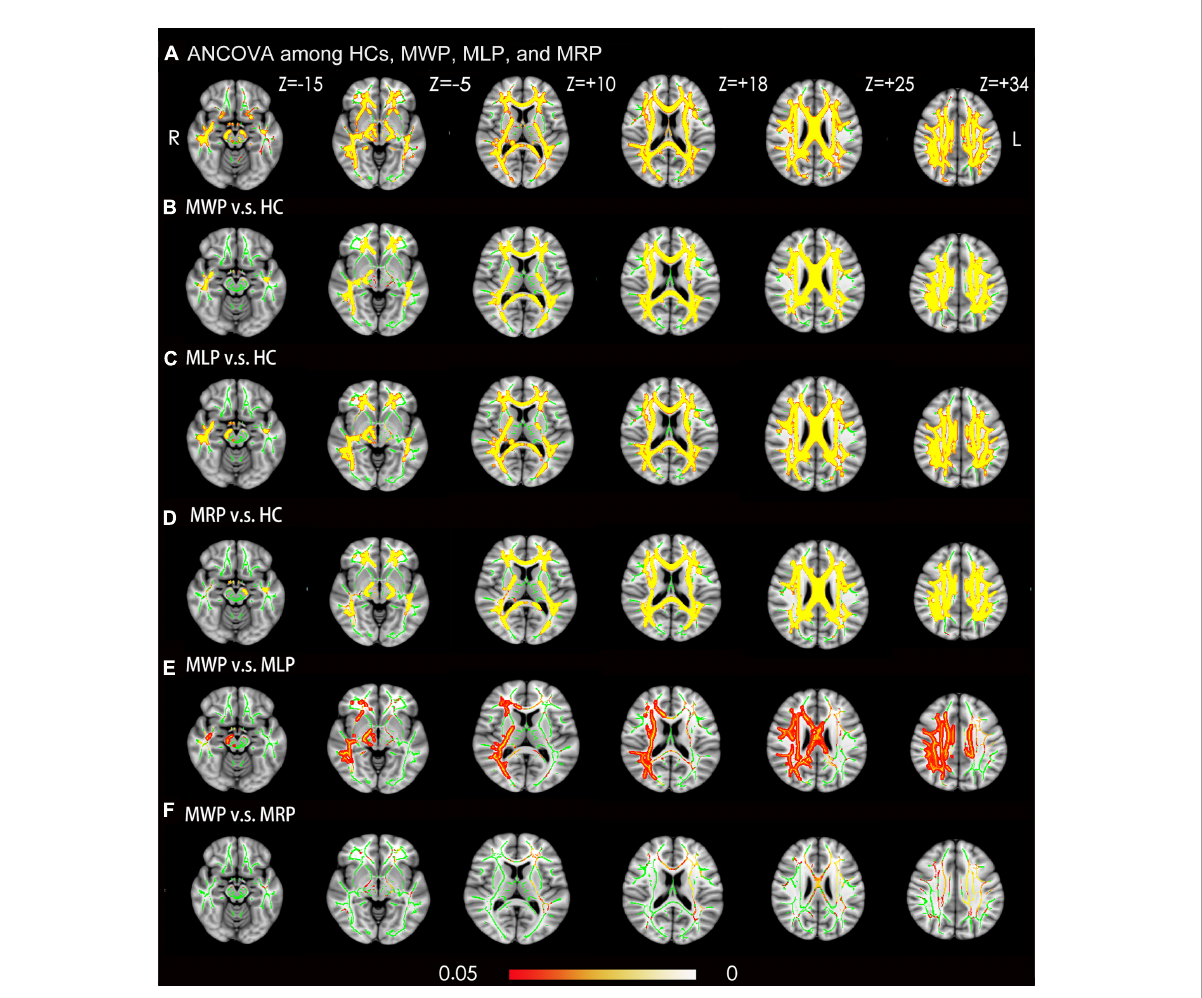
FIGURE3 Voxel-wise TBSS analysis results of mean kurtosis (MK) images across MMD patients with or without limb paresthesia and healthy controls (HCs). (A) Significant differences in MK (red-yellow) between patients without acroparesthesia (MWP), patients with left-limb paresthesia (MLP), patients with right-limb paresthesia (MRP), and HCs ( p < 0.05; family-wise error corrected based on the threshold-free cluster enhancement statistical image). Post hoc analyses revealed significant reductions (red-yellow) in MK in the MWP (B) , MLP (C) , and MRP (D) groups in comparison with the HCs. Post hoc analyses revealed significant reductions in MK in the MLP group (E) in comparison with MWP group, and no significant reductions in MK were observed in the MRP group (F) in comparison with the MWP group. Green represents the mean white matter skeleton of all participants. The color scale (red-yellow) represents significant differences between groups, with colored regions exceeding the significance threshold of P < 0.05. The left side of the image corresponds to the right hemisphere of the brain. ANCOVA, analysis of covariance.